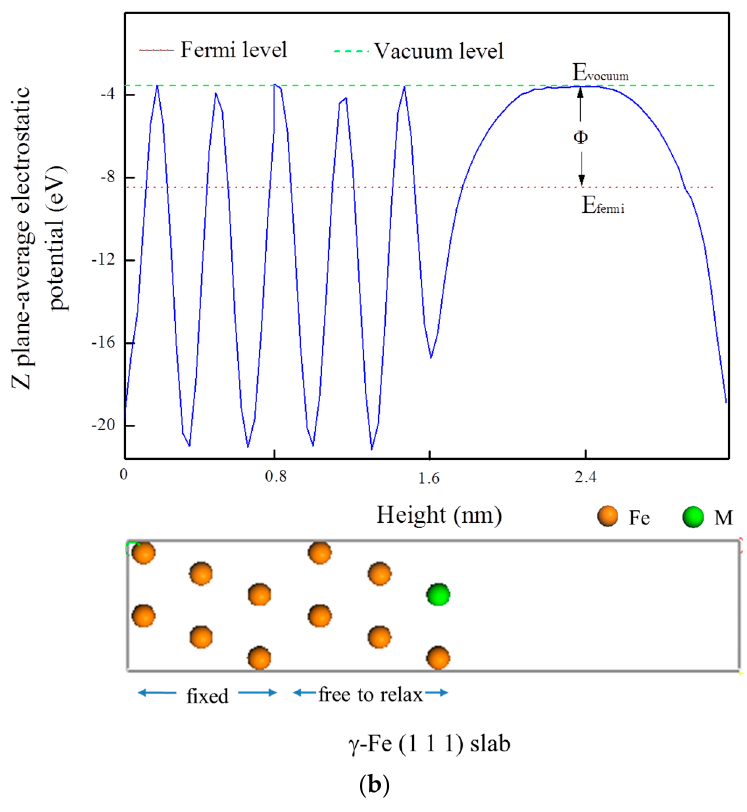
Figure 6. ( a ) Plane-averaged electrostatic potential curve of N -terminated Cr 2 N(0001) surface model; ( b ) Plane-averaged electrostatic potential curve of γ -Fe(111) surface model after different solution atoms introduced (M = Mn, V, Ti, Mo, Ni).